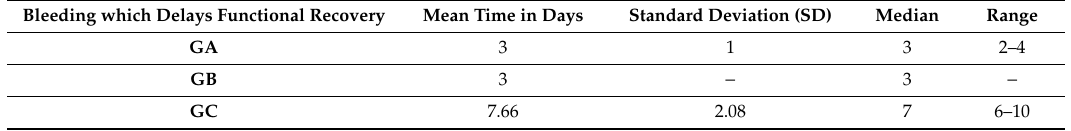
Table 2. Time to functional recovery (days) in patients with bleeding.